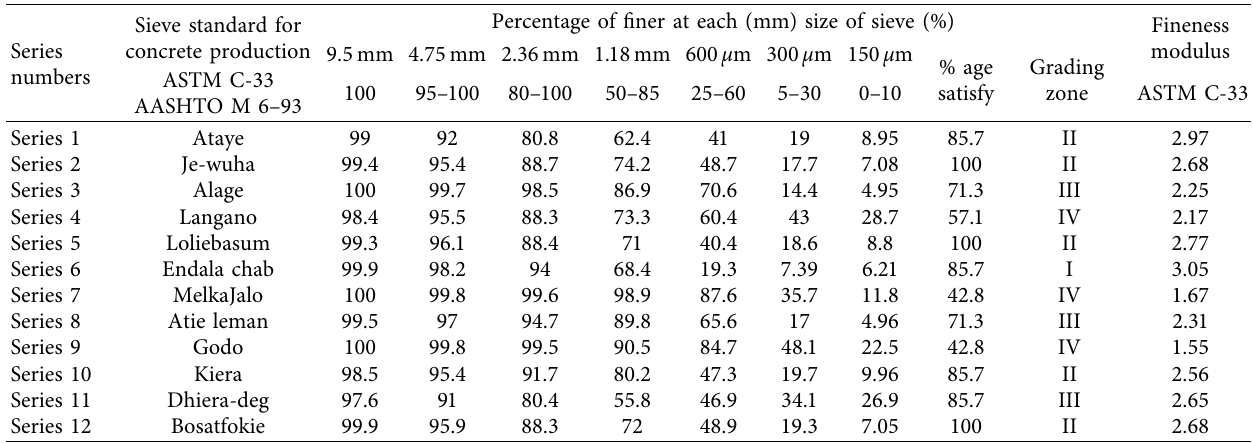
Figure 8: Sieve analysis test (source: test results conducted for this study). Table 2: Sieve analysis results and finesse